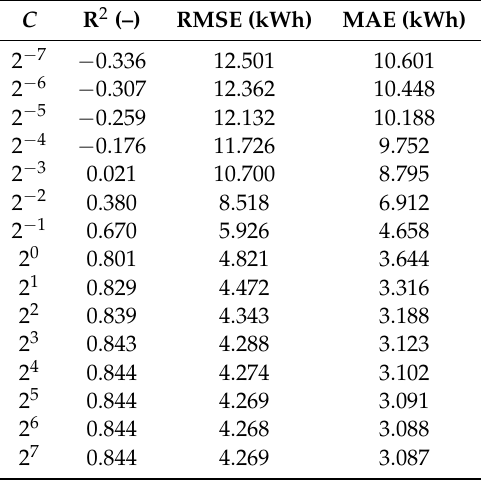
Table 5. Results of different C , where (cid:101) = 0.1.